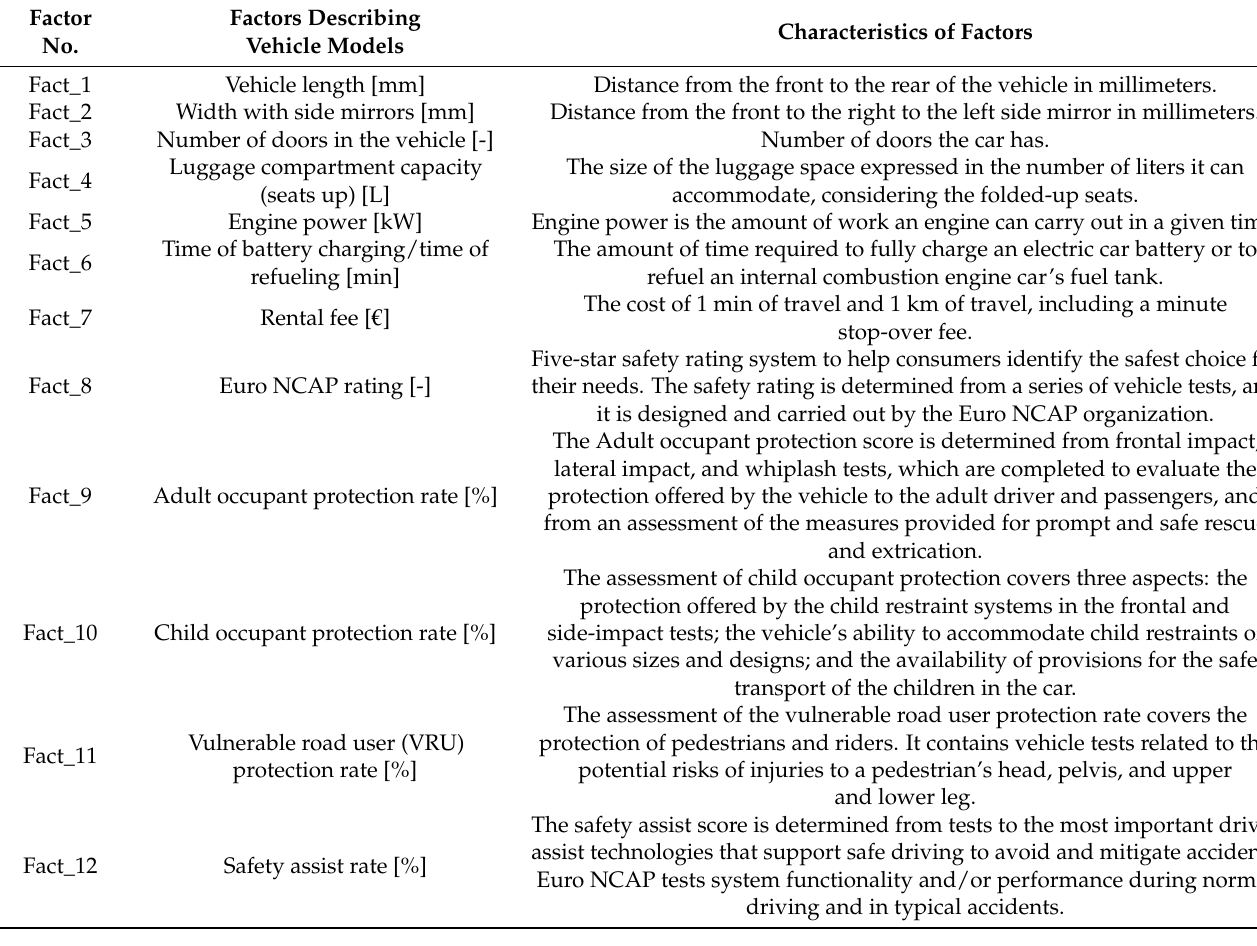
Table 2. Factors characterizing decision